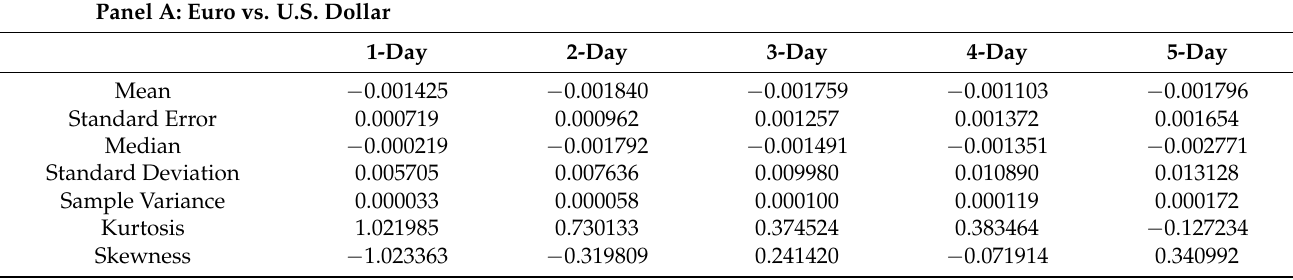
Table 1. Summary Statistics of